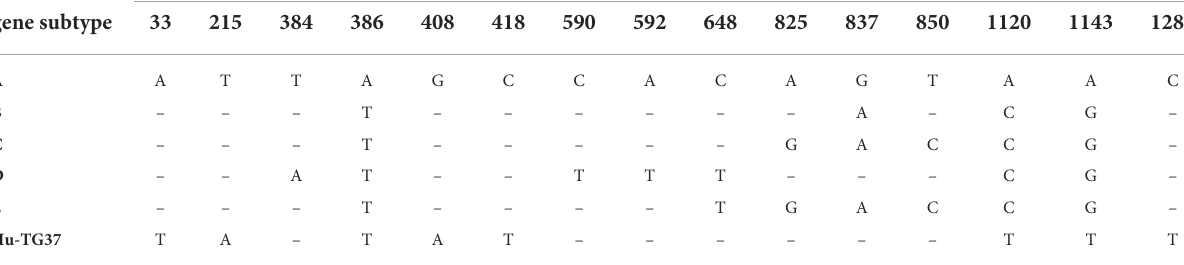
TABLE 2 Site-specific variations among 18S rRNA gene subtypes of Trichomonas gallinae and Trichomonas sp. Hu-TG37 compared to positions in EU215373 used as a reference sequence (identical with genotype A). 18S rRNA Position (in which the nucleotide is indicated